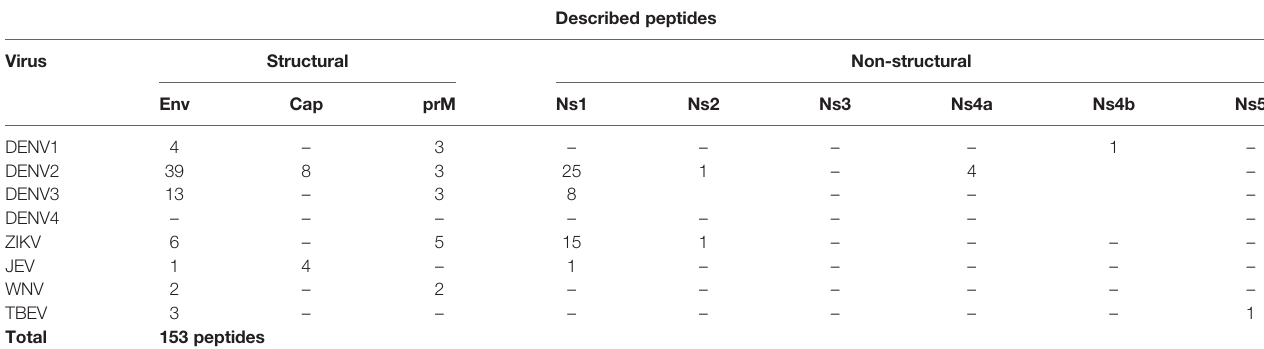
TABLE 1 | Quantitative summary of all described peptides included in this review, indicating peptide origin region.